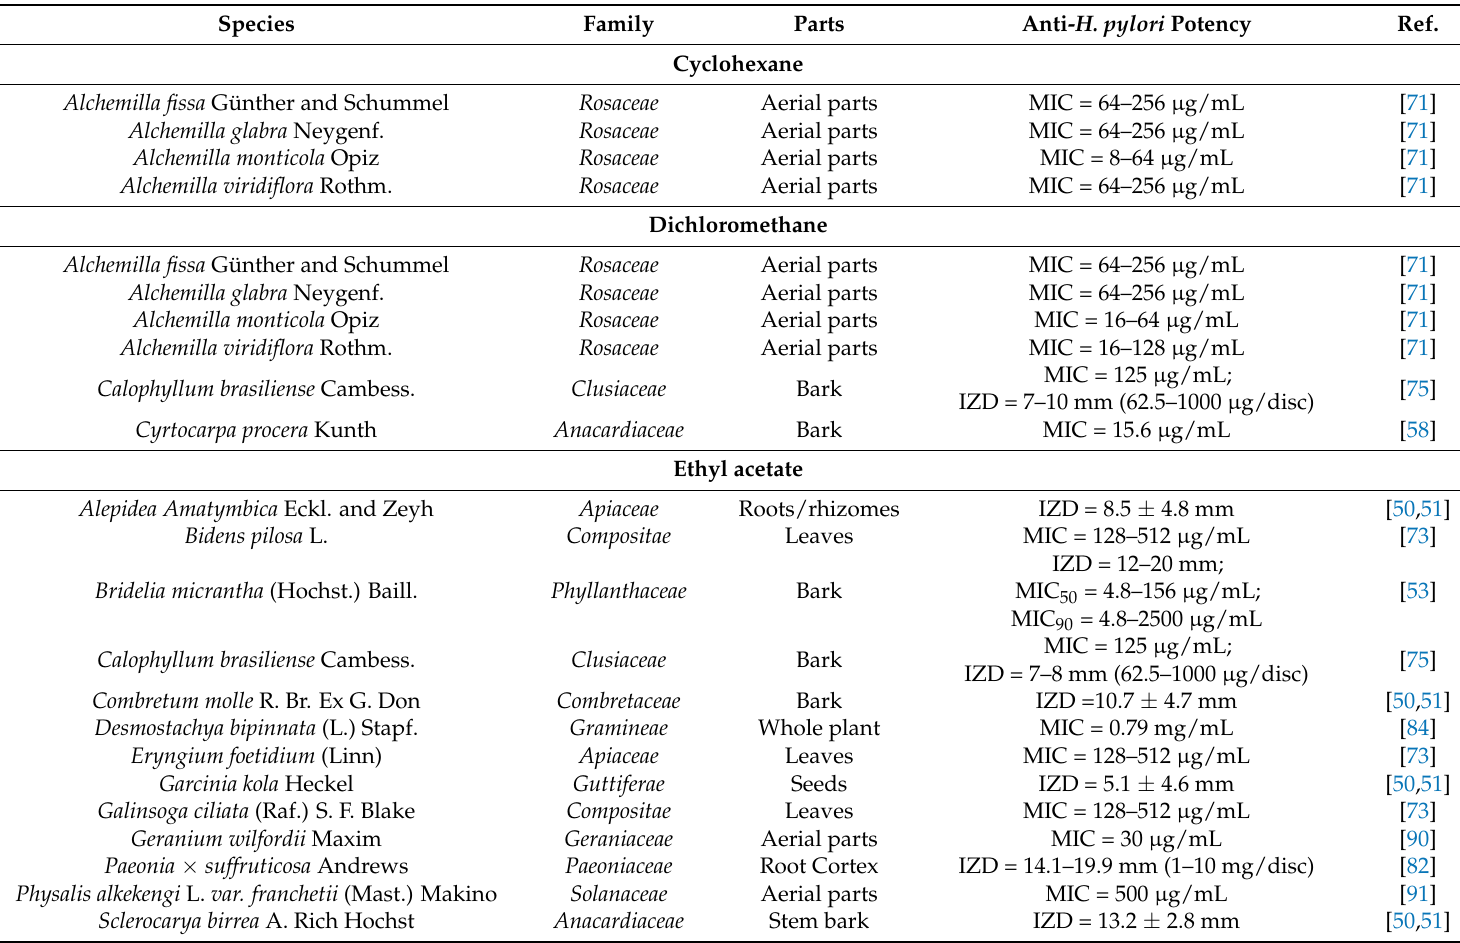
Table 9. Plant cyclohexane, dichloromethane, ethyl acetate, n-Butanol, n-Hexane, and other extracts with anti- H. pylori activity. Species